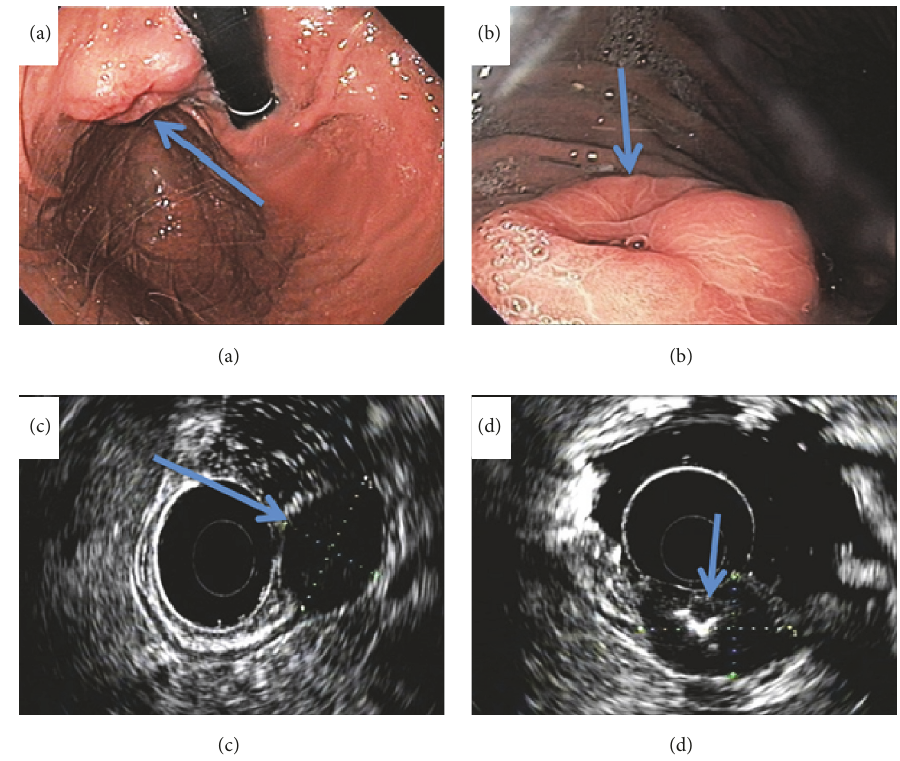
Figure 1: Esophagogastroduodenoscopy (EGD) and endoscopic ultrasound (EUS) of the gastric mass. (a)-(b) EGD shows the 3.5 × 2.5 × 1.5 cm subepithelial gastric mass with central umbilication (blue arrow). (c)-(d) EUS shows the gastric mass is hypoechoic (blue